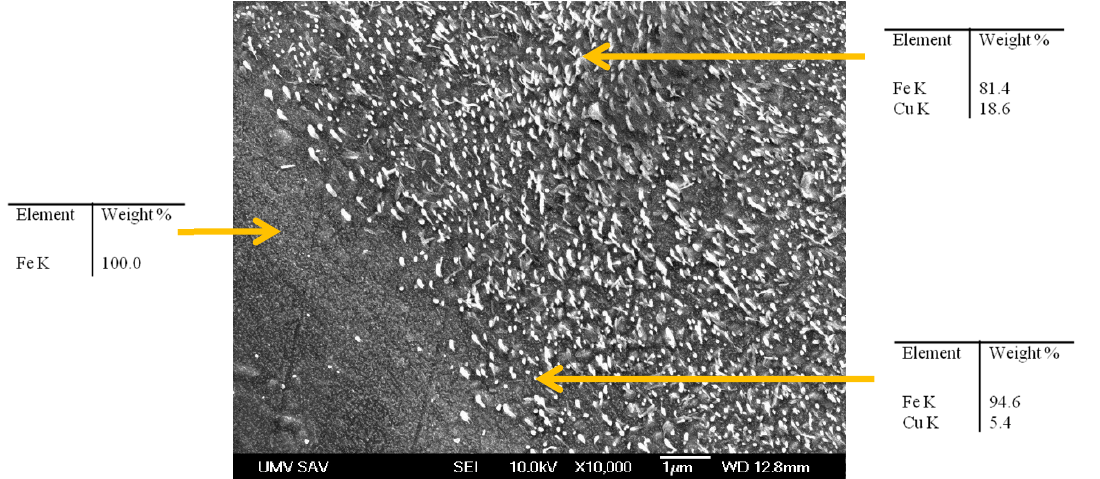
Figure 7. Adjoining copper-bearing and copper-free grain regions, and the elemental composition identified by EDX at different locations on the grain section. The specimen with 3.2 wt.% Cu is presented, SEM.